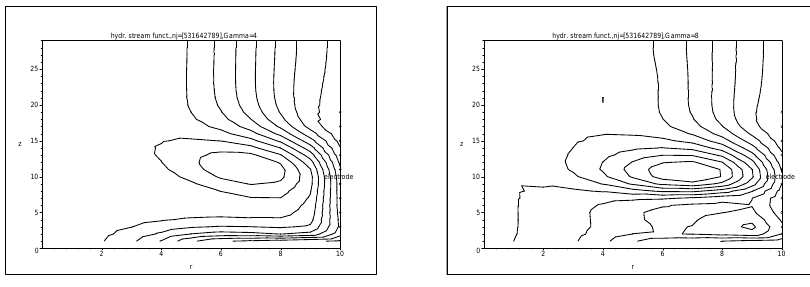
Figure 8. The stream functions for nj = [531642789] , ψ ∈ ( − 0 . 13 , 0 . 18) , Γ = 0 .